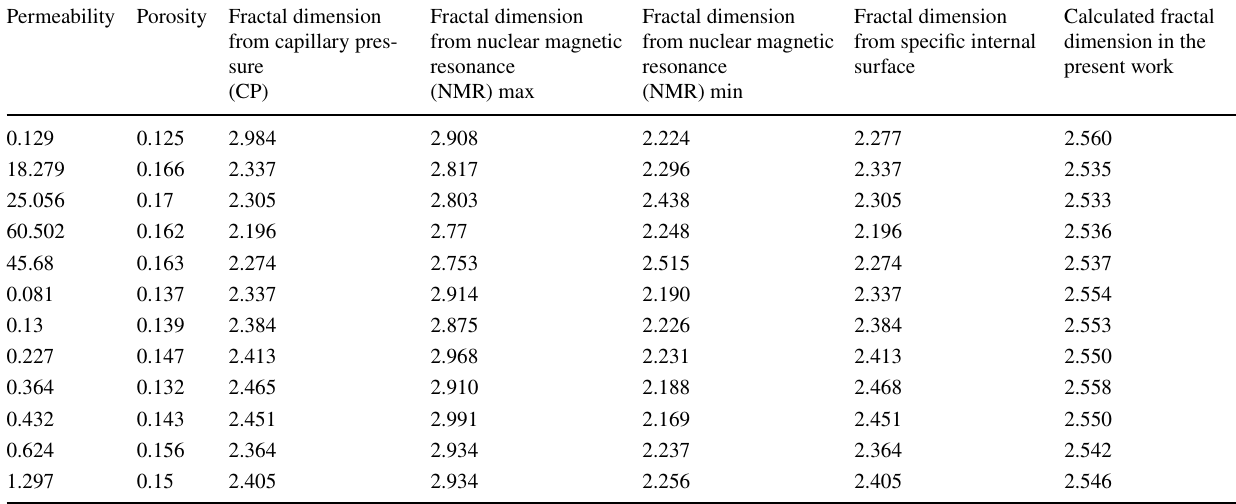
max maximum value, min minimum